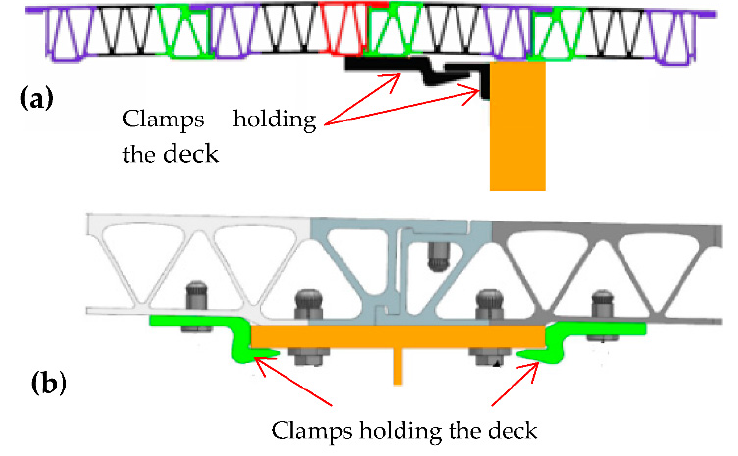
Figure 3. Typical deck-to-girders connection systems: ( a ) deck/glulam beam connection and ( b ) deck/steel girder connection.